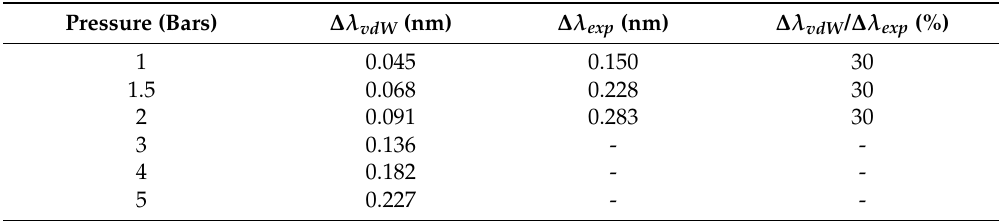
Table 1. Summary of the FWHM of the van der Waals broadening compared with the experimental FWHM of the six experimental spectra of the He I 492 nm